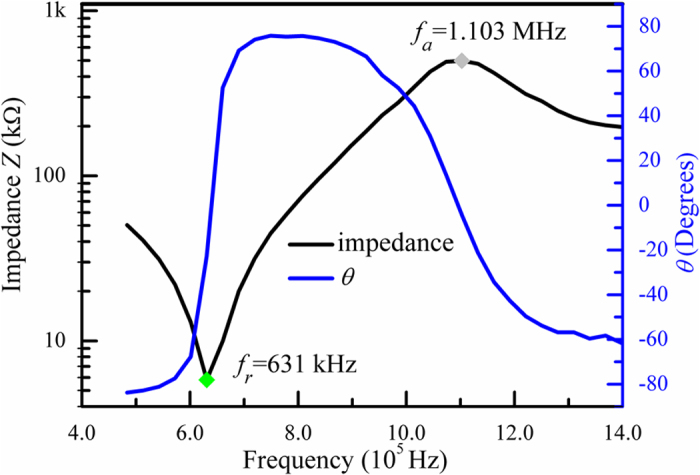
Room-temperature k33 resonator impedance spectra of K0.39Na0.61Ta0.42Nb0.58O3 single crystal.